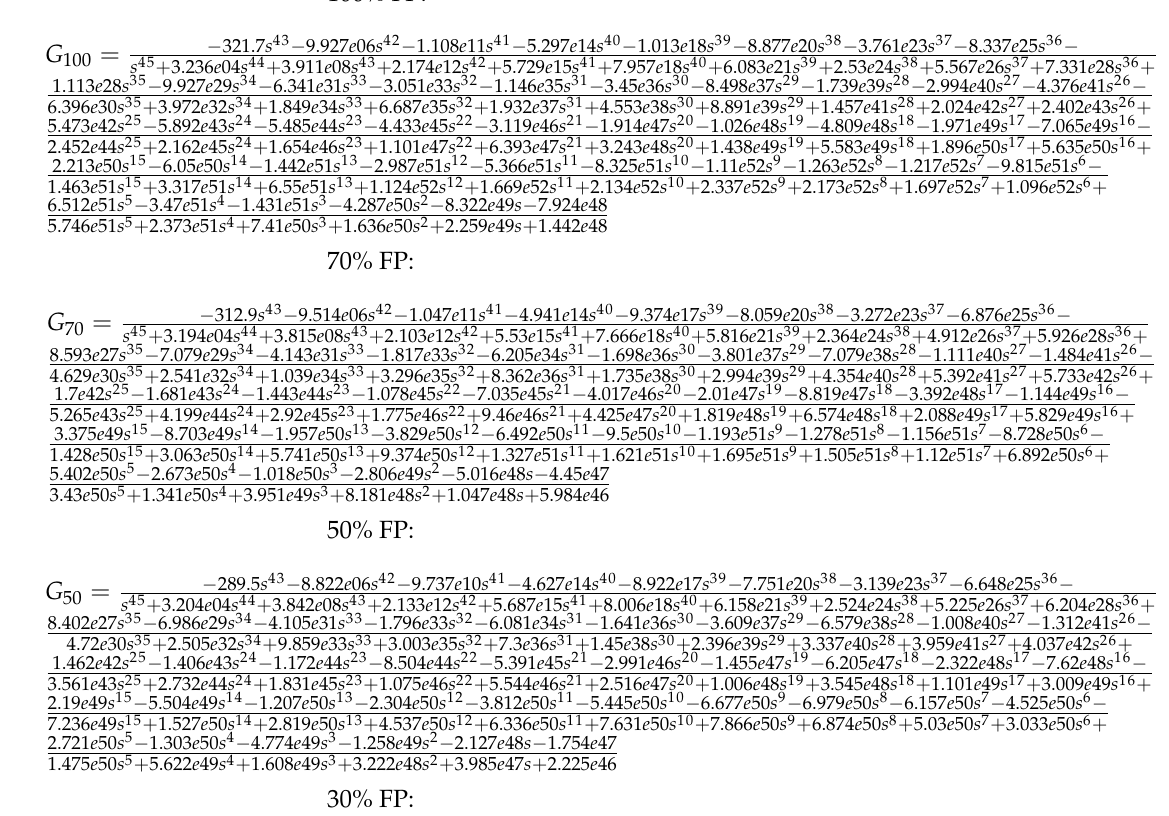
Figure A2. Primary side outlet temperature under different step disturbances in Ref. [23]. Transfer functions of 100%, 70%, 50% and 30% FP are as follows (the input is feedwater flow (kg/s) and the output is LBE outlet temperature of OTSG ( ◦ C)): 100% FP: